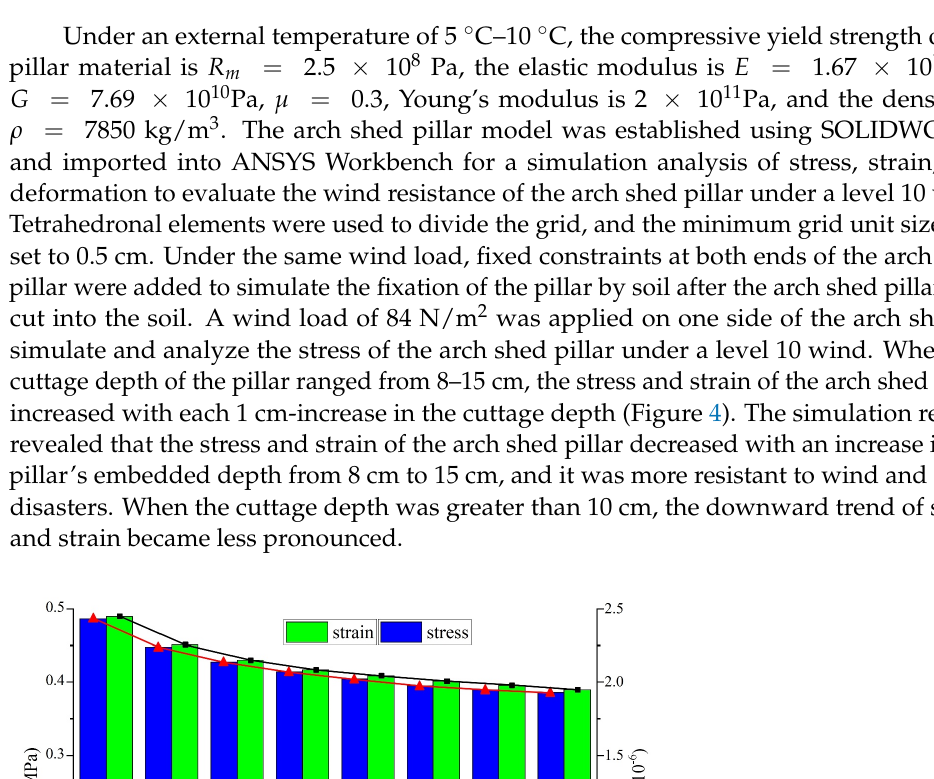
Figure 4. Pillar cuttage depth and wind resistance analysis of the arch shed.